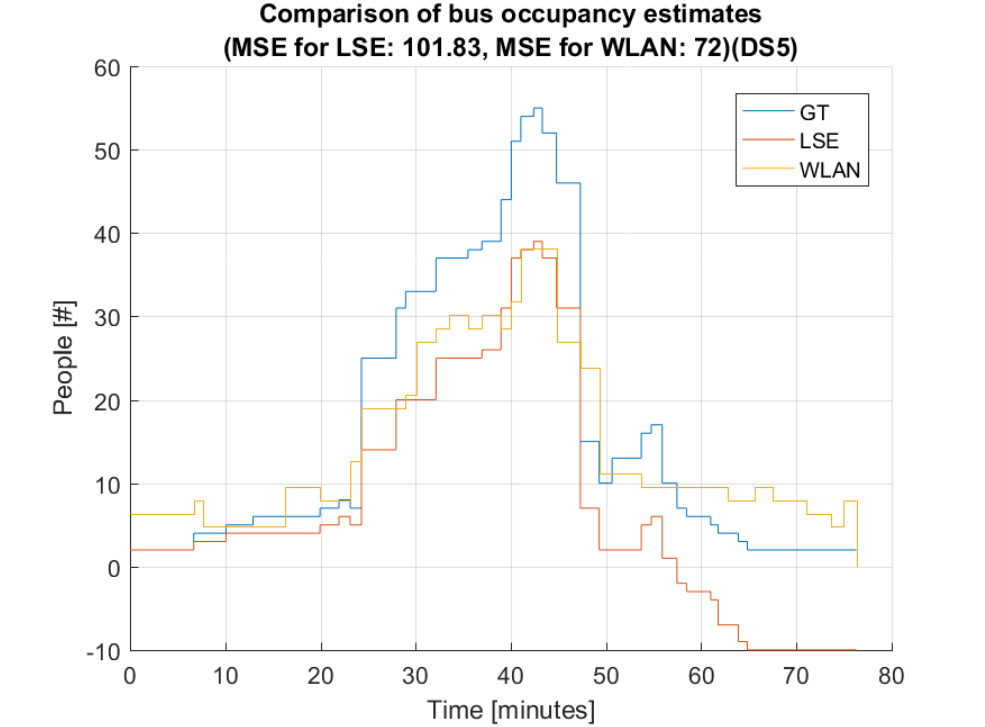
Figure 8. Comparison of LSE and WLAN with GT based on data set 5